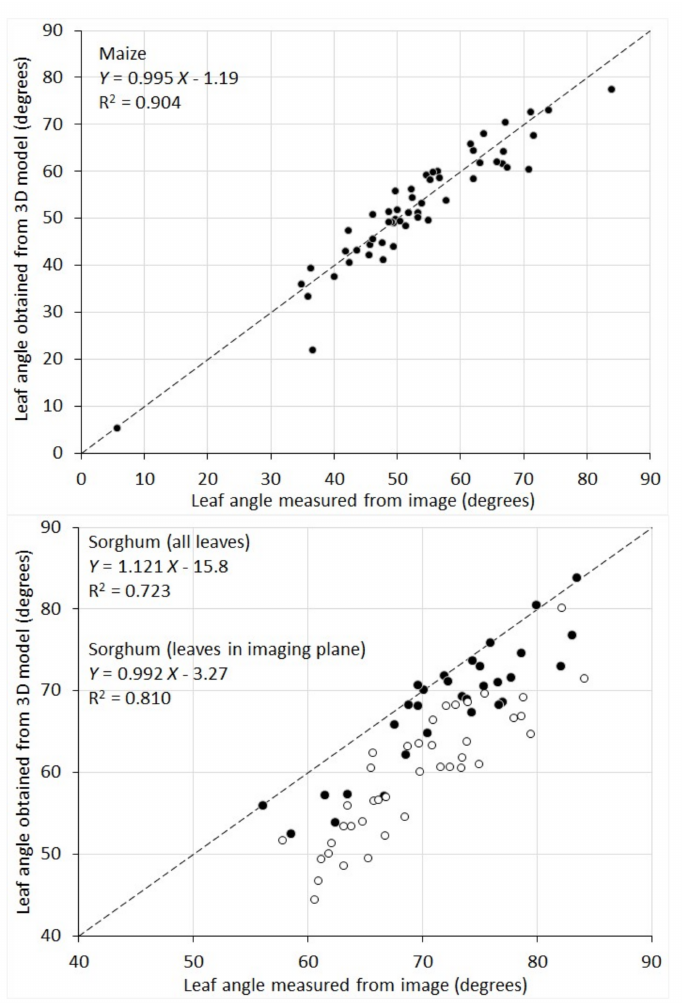
Figure 8. Scatterplot of individual leaf angle of ten maize and ten sorghum plants measured from their RGB images vs. obtained from 3D plant models. For sorghum, solid dots represent the leaves aligned in the imaging plane and hollow dots represent the leaves not in the imaging